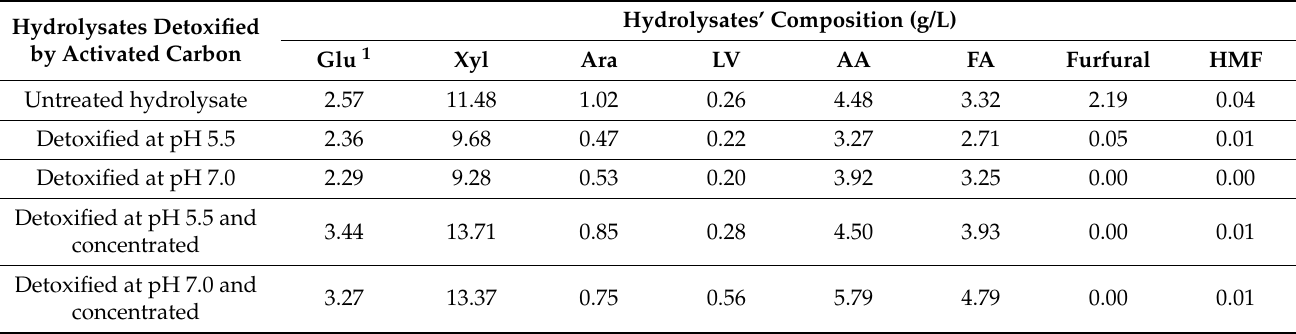
Table 1. Cardoon hydrolysates’ composition on monosaccharides and inhibitors before and after activated carbon detoxification and